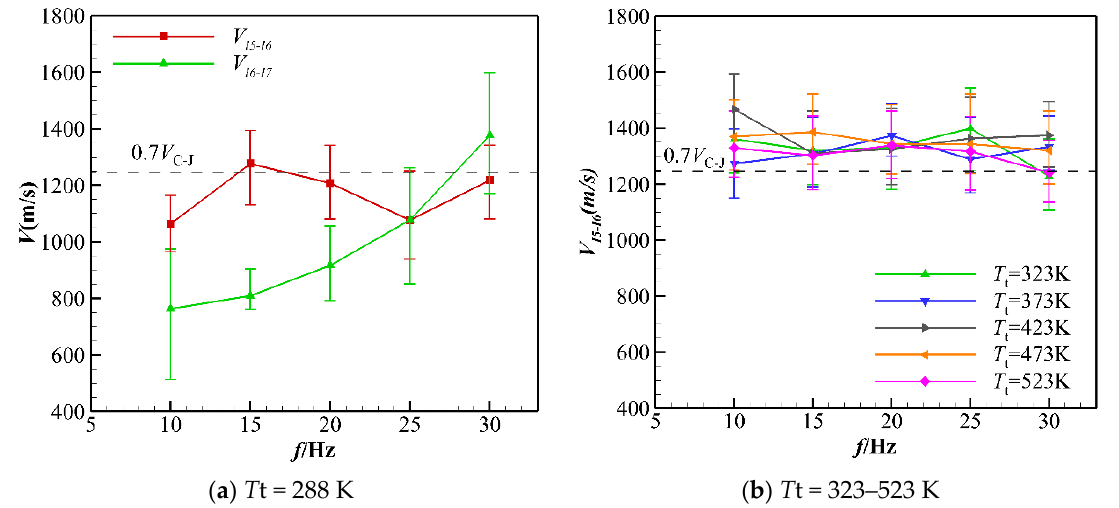
Figure 4. Flame propagation velocity in PDC measuring point 5~6 and measuring point 6~7 at dif- ferent working conditions.